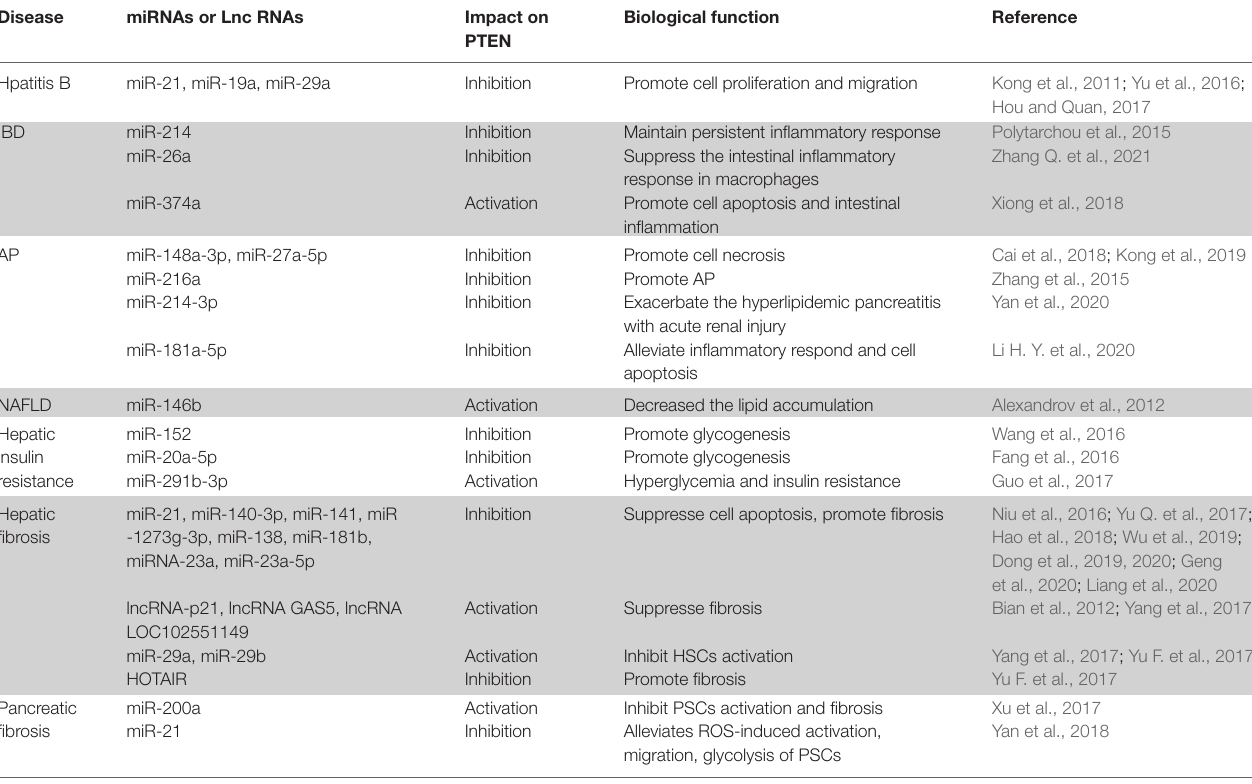
TABLE 1 | The influence of microRNAs and long non-coding RNAs on PTEN in non-neoplastic digestive diseases. Disease miRNAs or Lnc